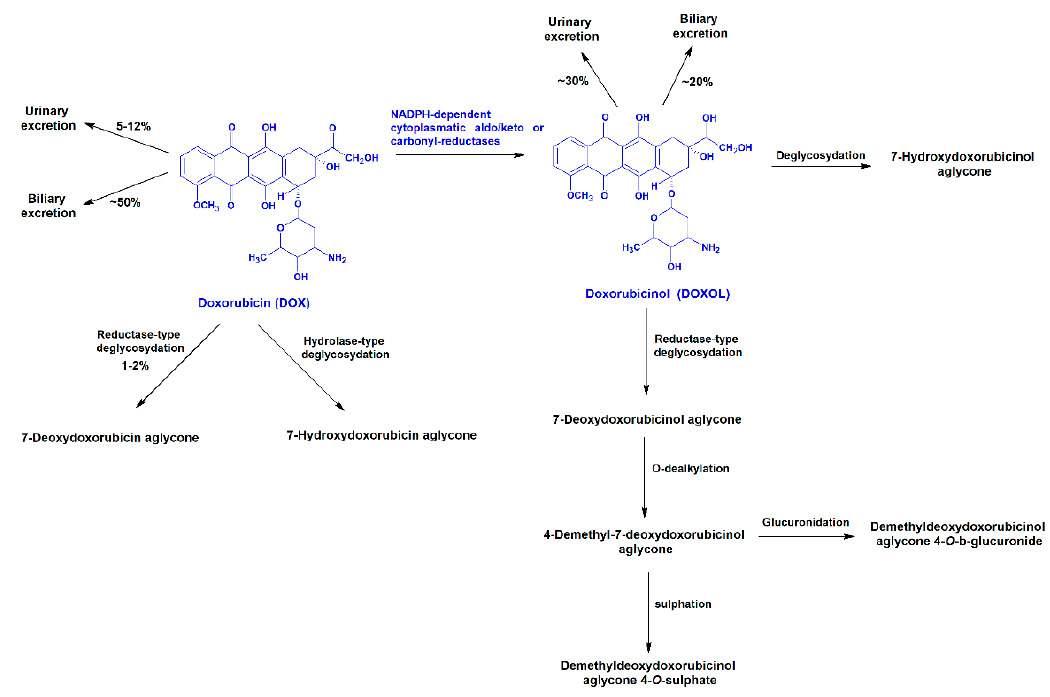
Figure 2. Metabolism of doxorubicin (DOX) [40,43,44].